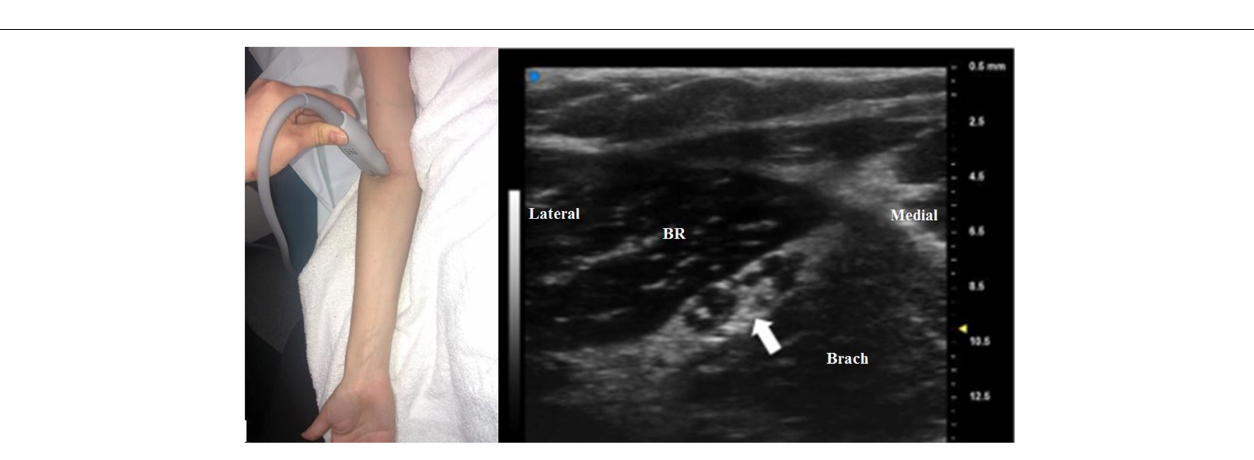
Frontiers in Neurology |